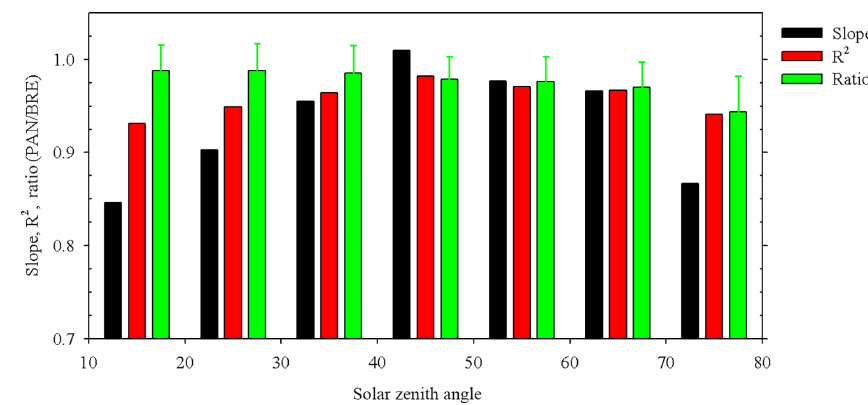
Figure 8. Slope, R 2 , and the ratio value for the real-time data between BRE and PAN with respect to the SZA change.